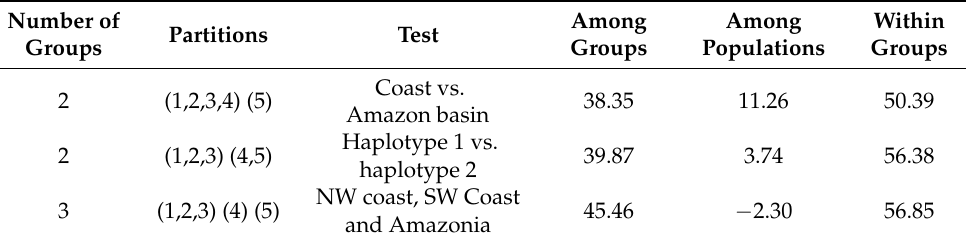
Table 3. Analysis of the molecular variance for five Ecuadorian populations of the Asian tiger mosquito.